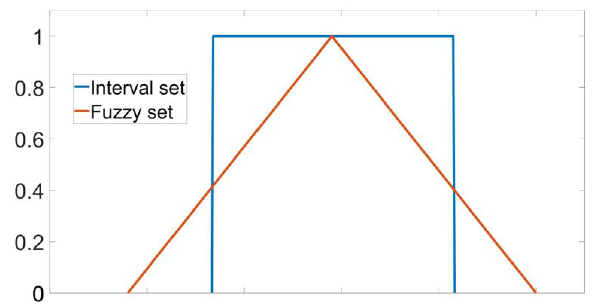
Figure 1. Fuzzy membership